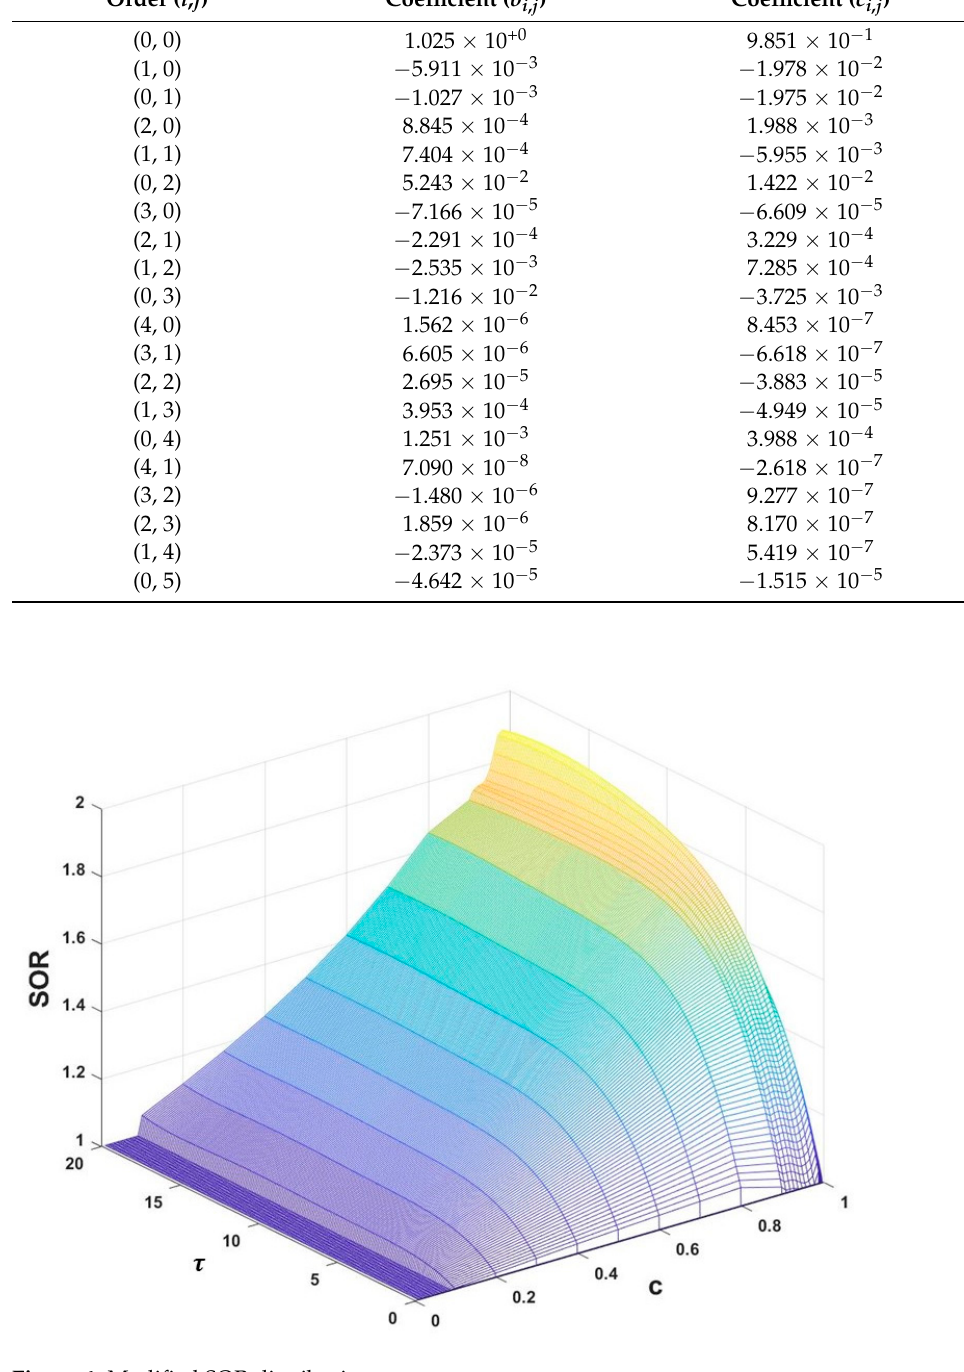
9 of 17 Table 3. Polynomial fitting coefficients for relaxation factors. Order ( (cid:2191), (cid:2192) )